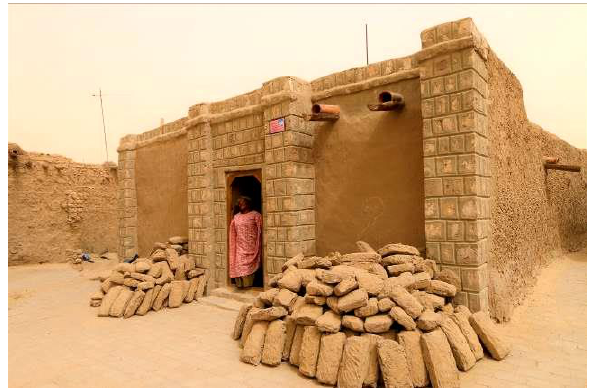
Figure 9. Restored house of widow Nana Ber, ready to carry on with additional repairs © Joffroy T. CRAterre.